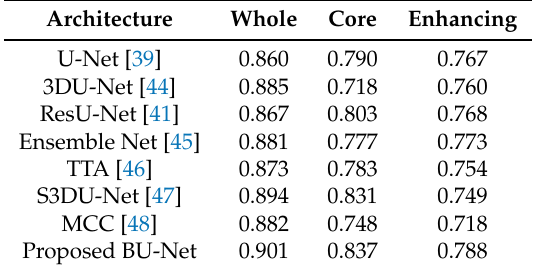
Table 4. Comparison of results with the BraTS 2018 validation dataset. (66 MRI scans).